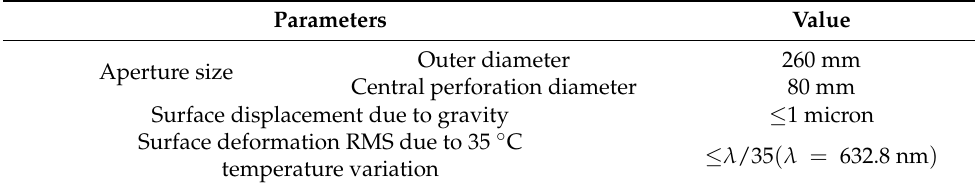
Table 2. Requirements of the primary mirror for an AOIS.